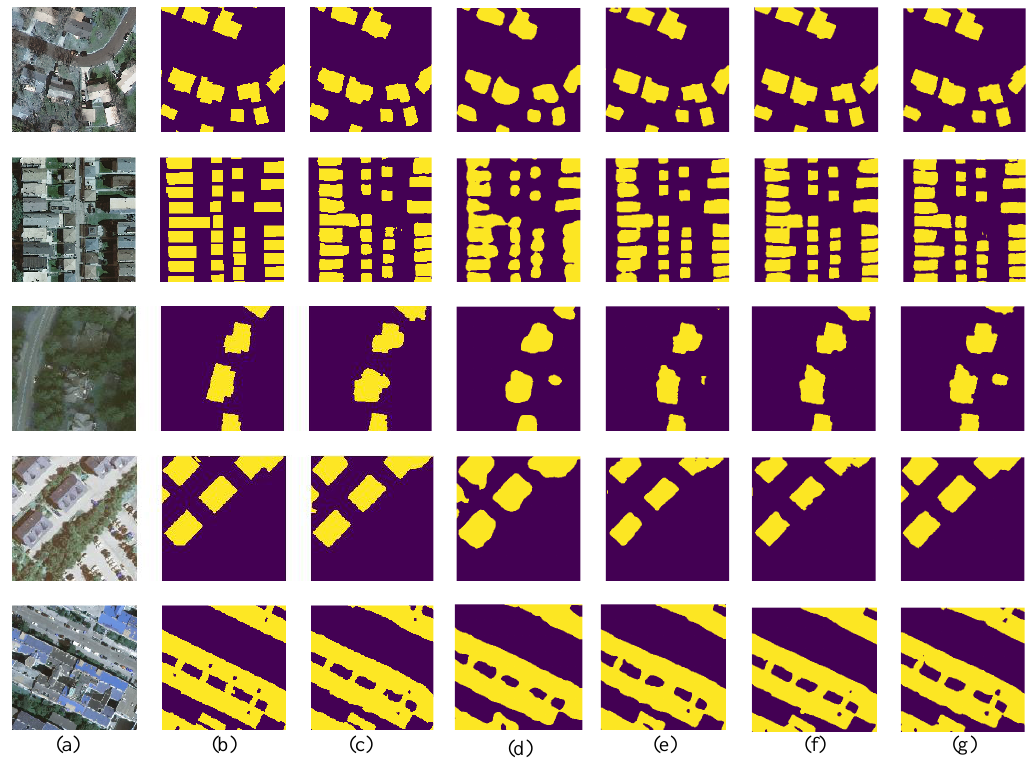
Figure 7. Predictions of some patches of different methods on the Inria dataset. ( a ) Original image, ( b ) Ground truth, ( c ) GMEDN, ( d ) FCN, ( e ) SegNet, ( f ) UNetPPL, ( g ) FCNDWT.